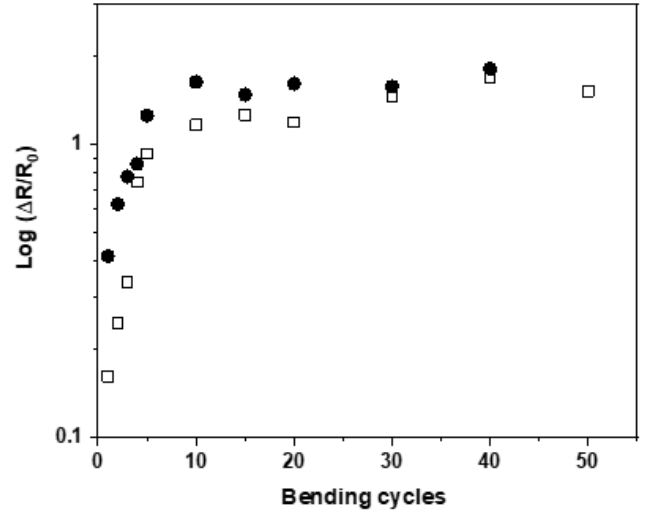
Figure 11. Variation in the resistance of PET/G fibers with different graphene loadings with the number of bending cycles (open squares and full circles correspond to loadings of 4 wt.% and 5 wt.%, respectively).